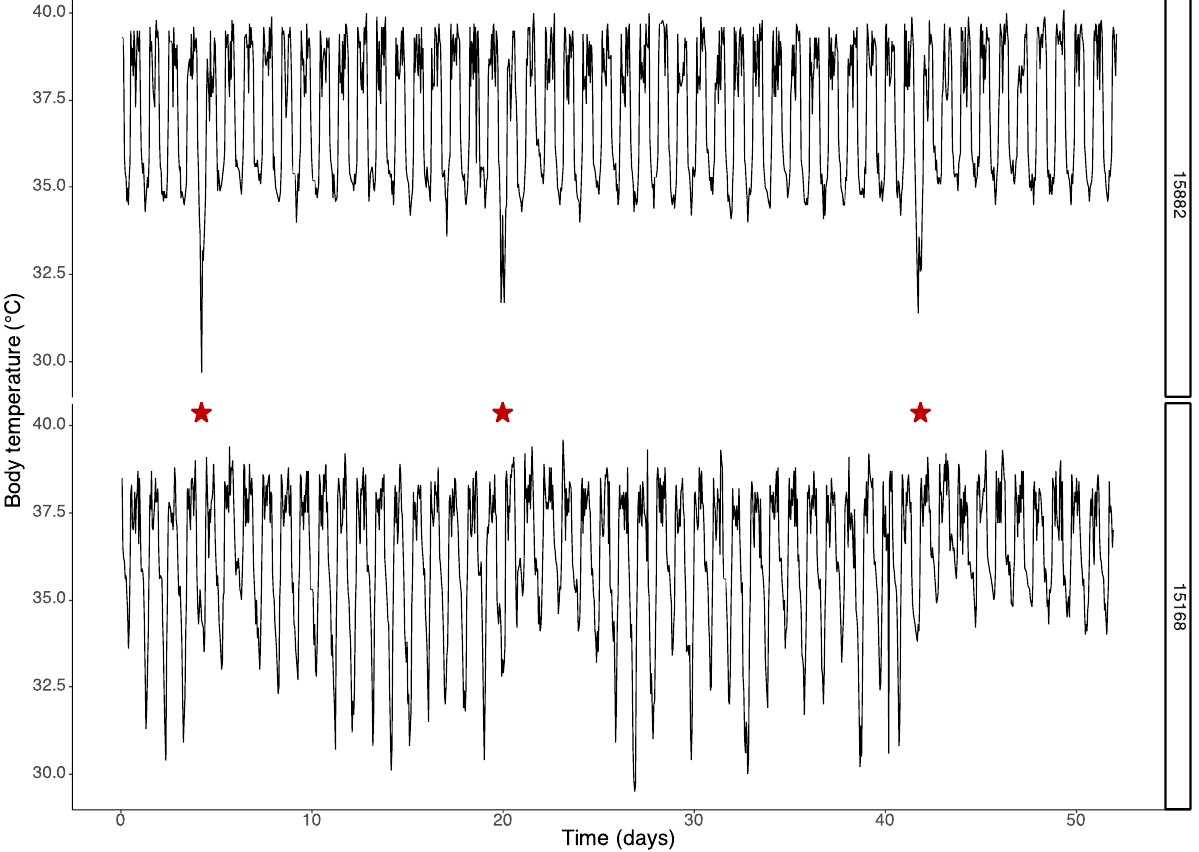
Figure 2. Two examples of daily rhythms in the core body temperature over a period of 50 days. In these recordings, the animals underwent three nightly cold exposures on days 5, 20 and 42 (indicated by a red star). The upper panel shows data from a tree shrew with stable daily rhythms in body temperature, where cold exposure resulted in a steep drop in temperature. The lower panel displays data from another tree shrew that had larger variability in daily core body temperature, and cold exposure resulted in an increase in core body temperature that lasted for several days up to a